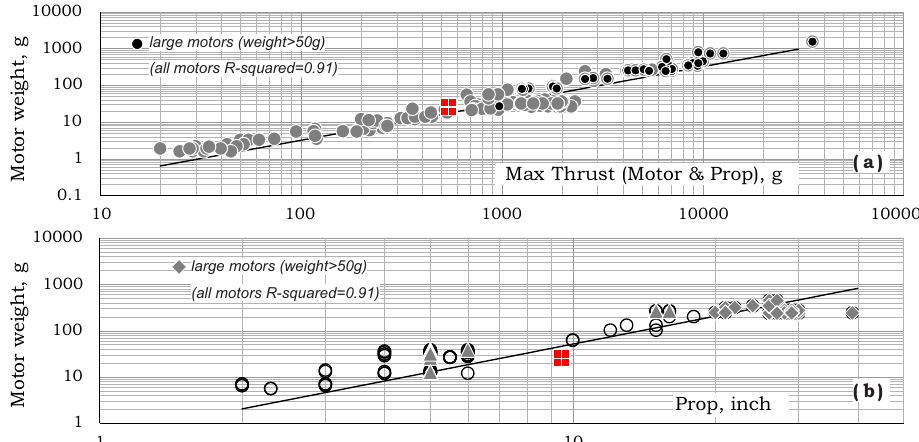
Figure 4. Motor weight design trends,